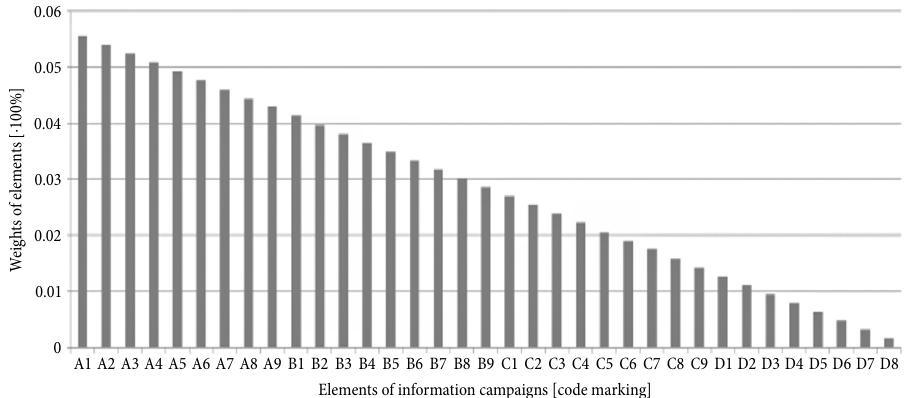
Fig. 3. Weights of importance reached in the way of Method of